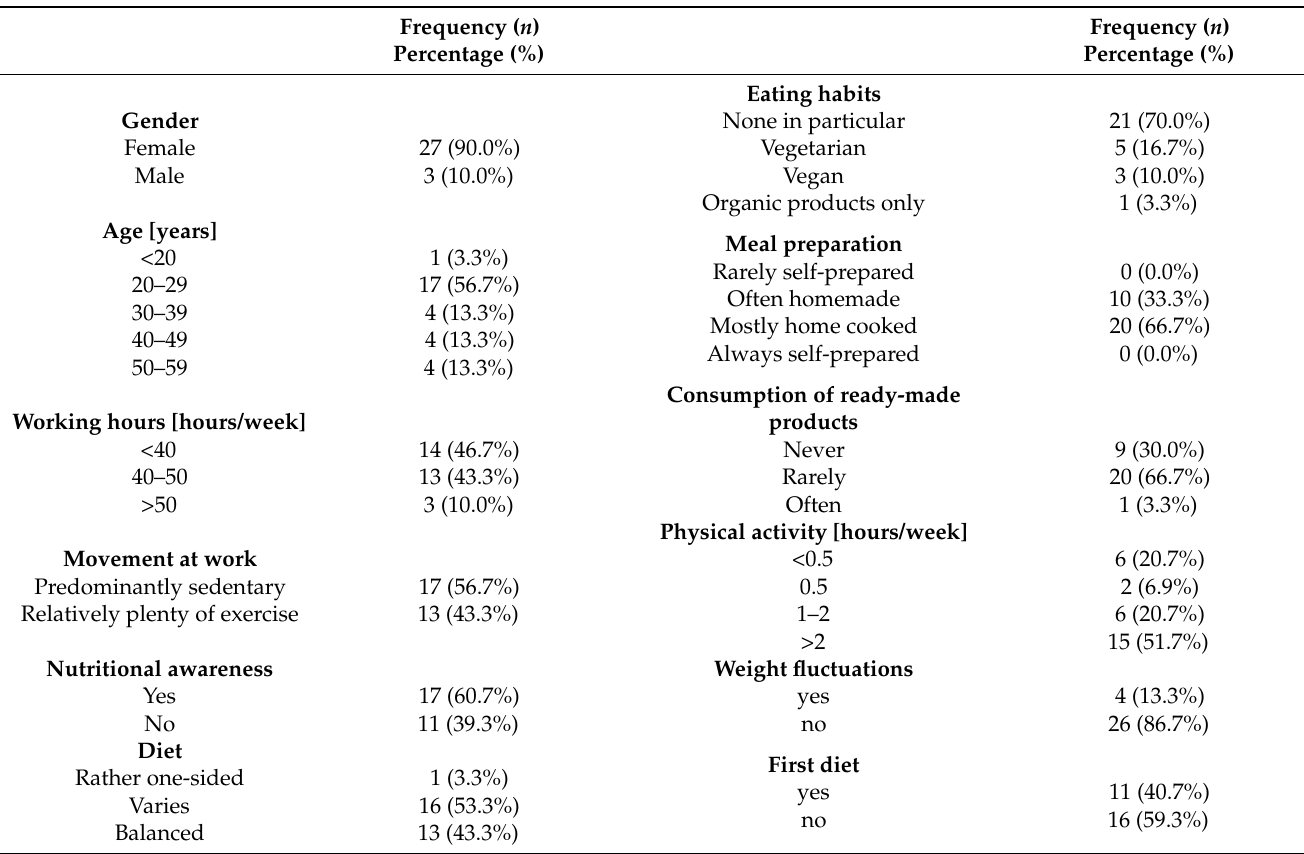
Table 2. Subjects’ characteristics ( n =